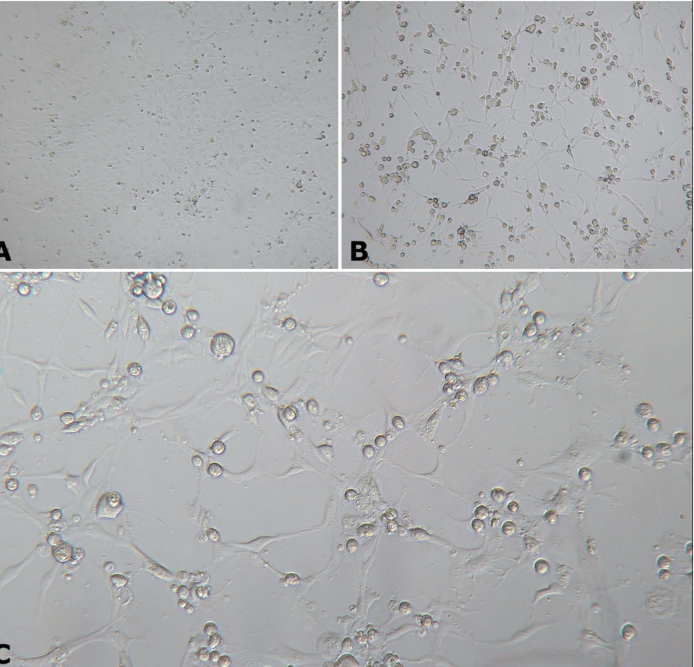
Figure 2. Morphology of OmB cells at 6 days post-inoculation with tilapia tissue homogenate. ( A ) Uninfected/normal OmB cells viewed at 40 × magnification. ( B , C ) Infected cells showing cyto- pathic effect of OmBs characterized by cell rounding viewed at 40 × ( B ) and 100 × ( C )